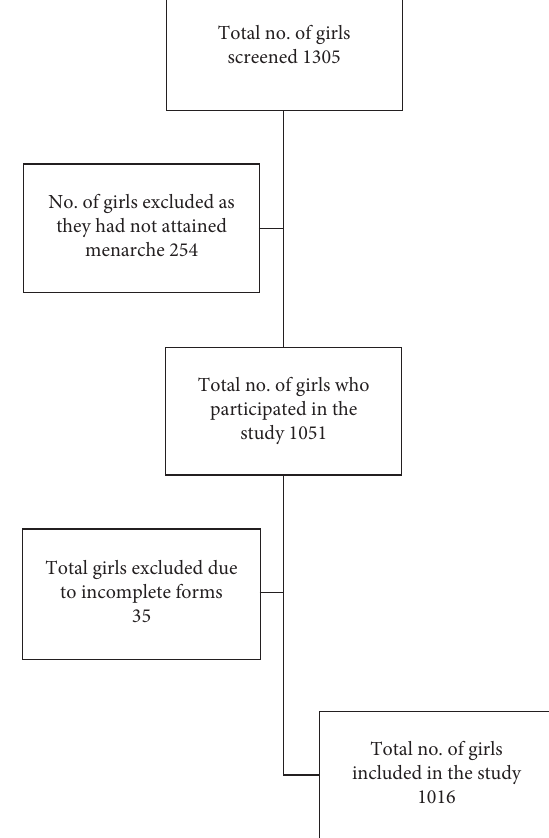
Figure 1: Strobe